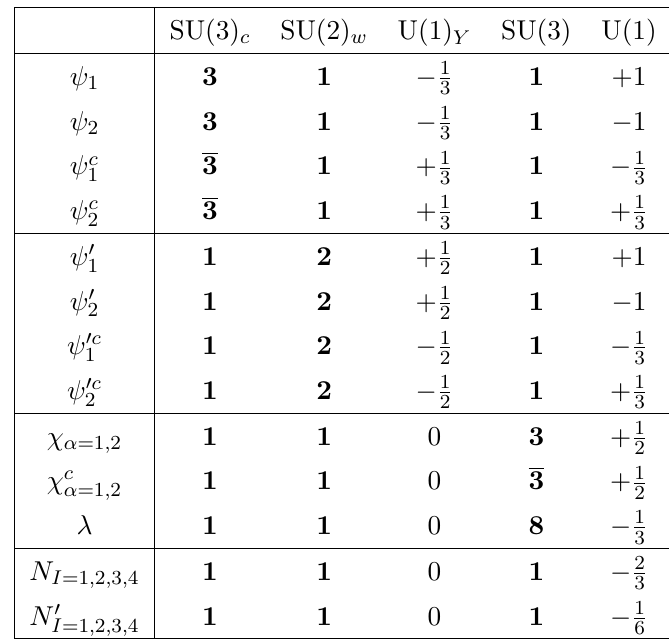
Table 2 . Field content beyond the SM. All fields are Weyl fermions. Note that the messengers ( ψ a , ψ 0 ) ⊕ ( ψ c , ψ 0 c ) form complete 5 a ⊕ 5 a multiplets of a grand-unified SU(5) SM gauge group, a a a but are chiral under U(1)